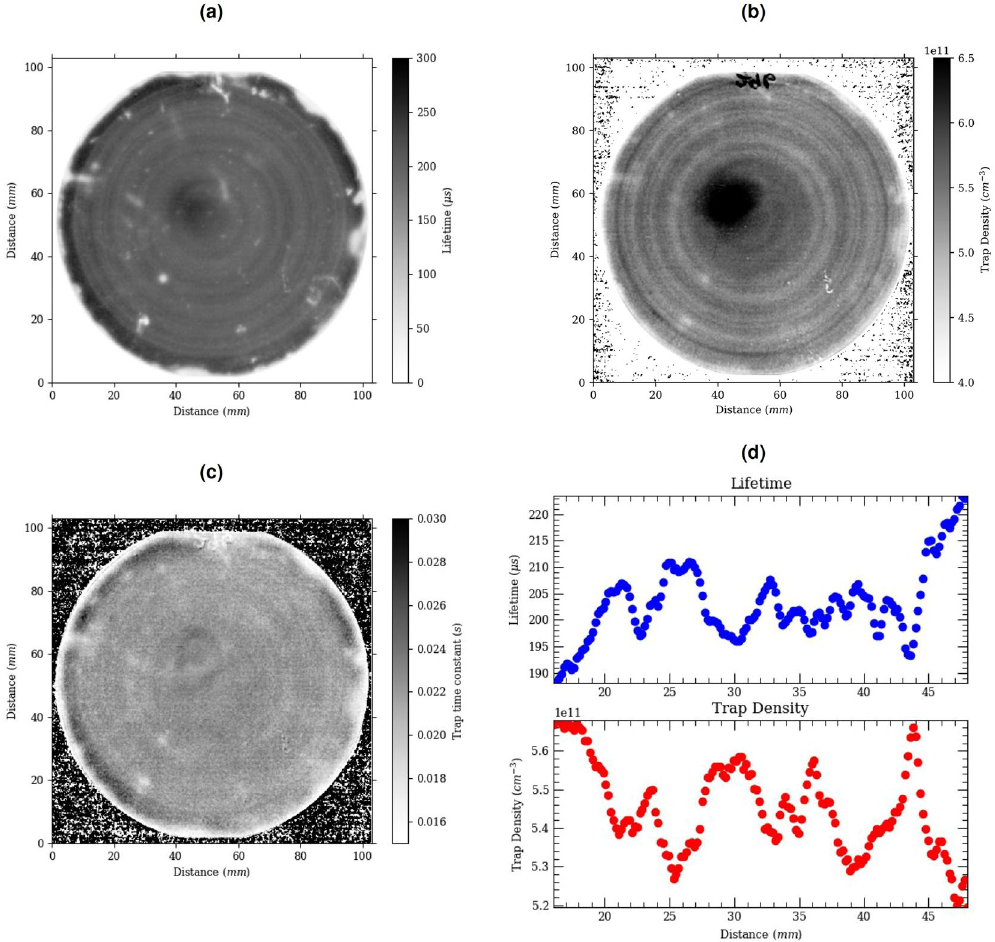
Figure 2. Sample with thermal donors. Image of the ( a ) effective lifetime ( b ) trap concentration ( c ) trap time constant. The sample without thermal donor is not shown here as the fit of the of the lock-in signal is just noise as shown in Fig. 1. ( d ) Profile of the effective lifetime and trap concentration. The dark area at the centre of the wavers in image a, b and c is related to the reflection of the cooled camera on the wafer. The camera is colder than the rest of the chamber which leads to an artifact that cannot be removed through the lock-in